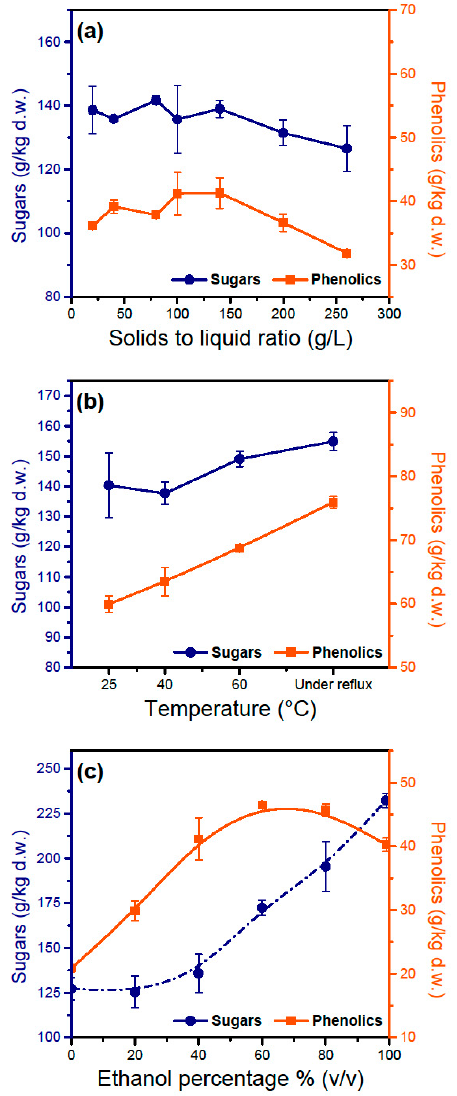
Figure 4. Effect of different parameters on the extraction sugars and phenolics from dry, pulverized olive leaves utilizing conventional solid–liquid extraction. ( a ) Variable: solid–liquid ratio; constant parameters: duration 20 min, 40% ( v / v ) ethanol as the solvent, and room temperature. ( b ) Variable: extraction temperature; constant parameters: duration 20 min, 70% ( v / v ) ethanol, solid–liquid ratio 100 g/L. ( c ) Variable: ethanol percentage in solvent; constant parameters: duration 20 min, room temperature, and solid–liquid ratio 100 g/L.